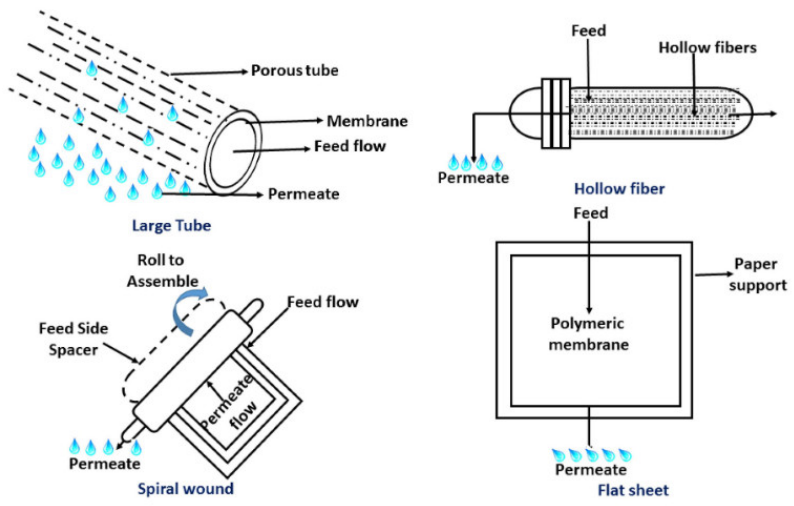
Figure 6. FO membrane configurations [58] (Permission No. 5322090221420).